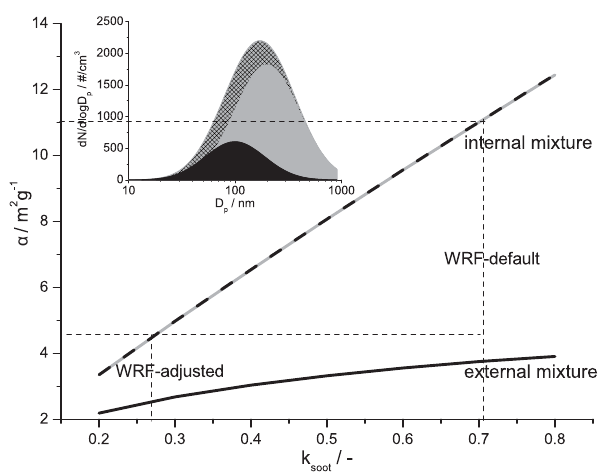
Figure 8. Mass absorption cross-section for externally and inter- nally mixed BC particles in dependence on the imaginary part ( k ) of the refractive index ( m = n + ik ) from Mie calculations. Val- ues are derived using spherical log normally distributed BC par- ticles ( N = 800, Dp g = 120nm, σ g = 1 . 9, ρ = 1 . 8gcm − 3 , m = 1 . 85 + ik ) and non-absorbing particles ( N = 2500, Dp g = 200nm, σ g =2, m = 1 . 55 + i 1 × 10 − 7